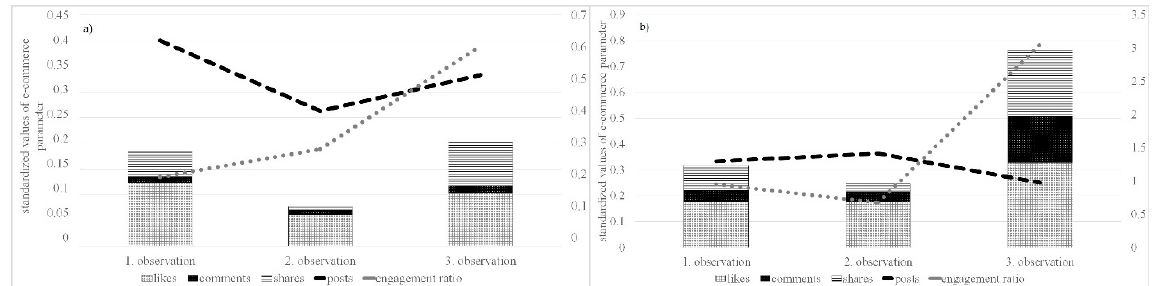
Figure 10. Engagement ratio and its components over individual observation periods: ( a ) working days; ( b ) weekends.